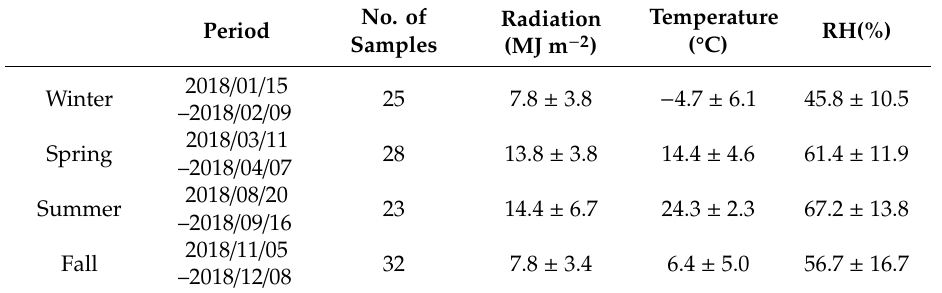
Table 1. Number of samples and meteorological parameters during the sampling period for each season.